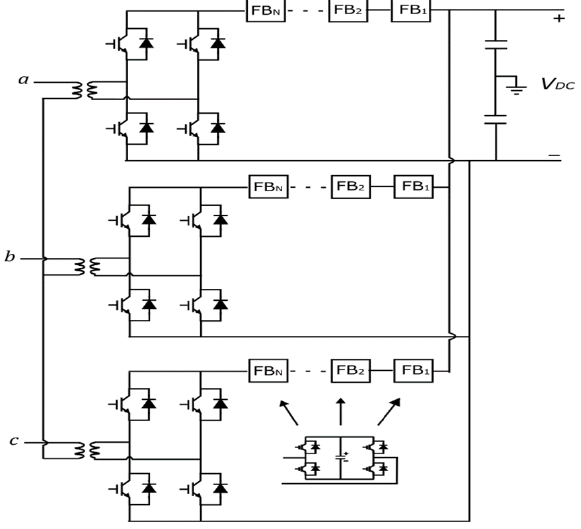
Figure 27. HMC with DC side HBSMs.